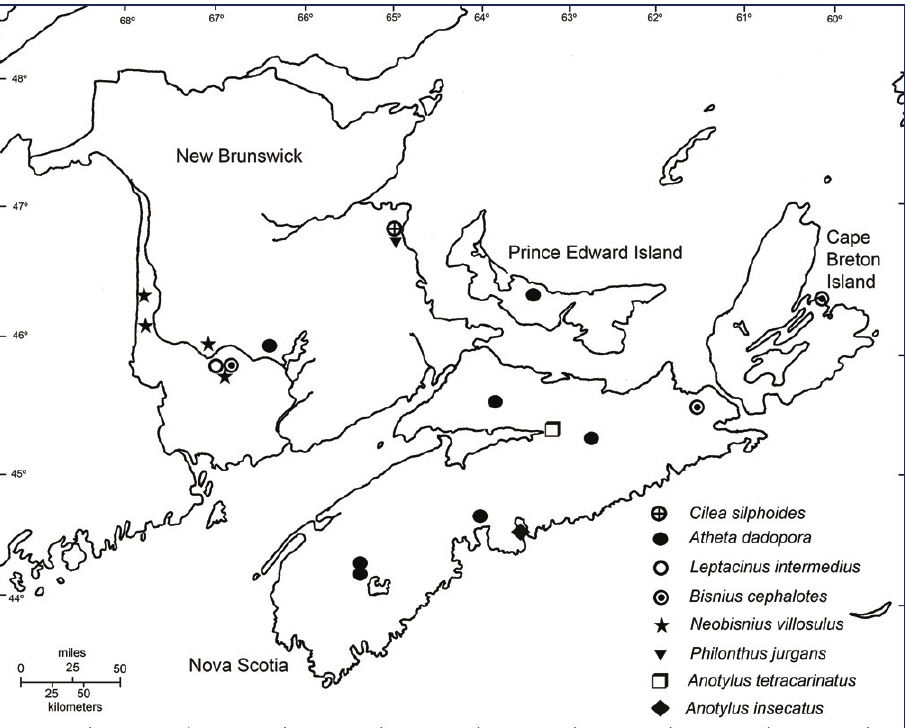
Fig. 5. Distribution of Cilea silphoides, Atheta dadopora, Leptacinus intermedius, Bisnius cephalotes, Neobis- nius villosulus, Philonthus jurgans, Anotylus tetracarinatus, and Anotylus insecatus in the Maritime Provinces of